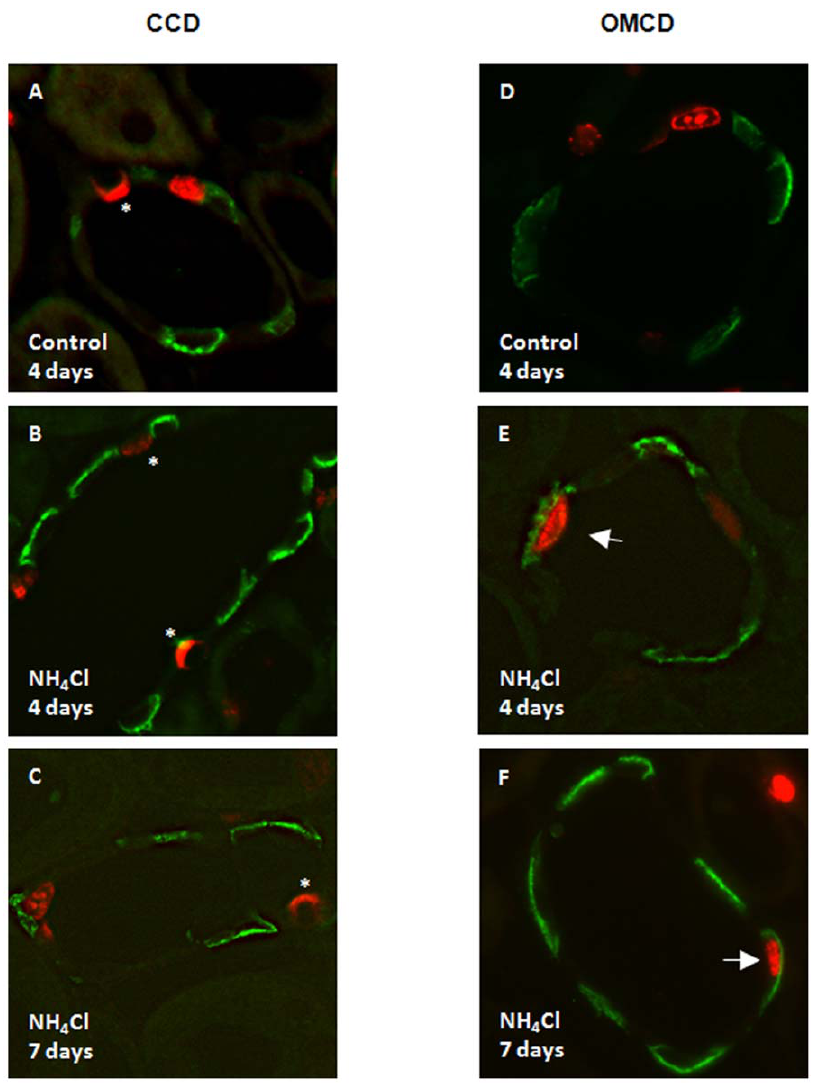
Figure 3. Proliferation of intercalated cells after 4 days of acidosis is observed in the OMCD but not CCD. Kidney sections were stained with antibodies against either the type A intercalated cell specific AE1 protein (green), or the non-type A intercalated cell specific pendrin protein (red, asterisk), and antibodies against PCNA (red nuclei). Animals were treated for 4 days with NH 4 Cl or were left untreated (controls). ( A–C ) Colocalization of PCNA and AE1 in some cells in the CCD after 4 or 7 days of NH 4 Cl treatment: Pendrin positive cells (*) in the CCD did not show PCNA labelling at any time point. ( D–F ) In the OMCD PCNA labelling was found under control conditions in AE1 negative cells (D) whereas colocalization (arrows) with AE1 could be observed after 4 and 7 days of metabolic acidosis (E,F).